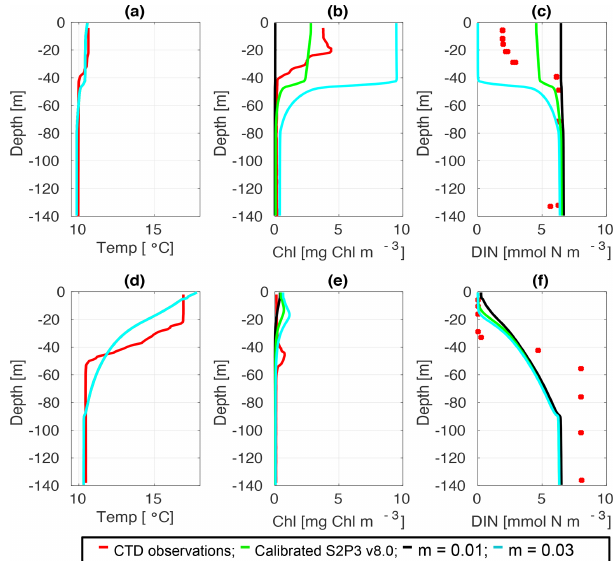
Figure C5. CTD observations from the SSB programme (red line) including data for springtime (20 April 2015) (a) temperature, (b) chlorophyll a , and (c) DIN (red dots); for summertime (24 Jul 2015) for (d) temperature, (e) chlorophyll a , and (f) DIN (red dots) along the calibrated S2P3 v8.0 model (green line), experiments m = 0 . 01 (black line) and m = 0 . 03 (cyan line).